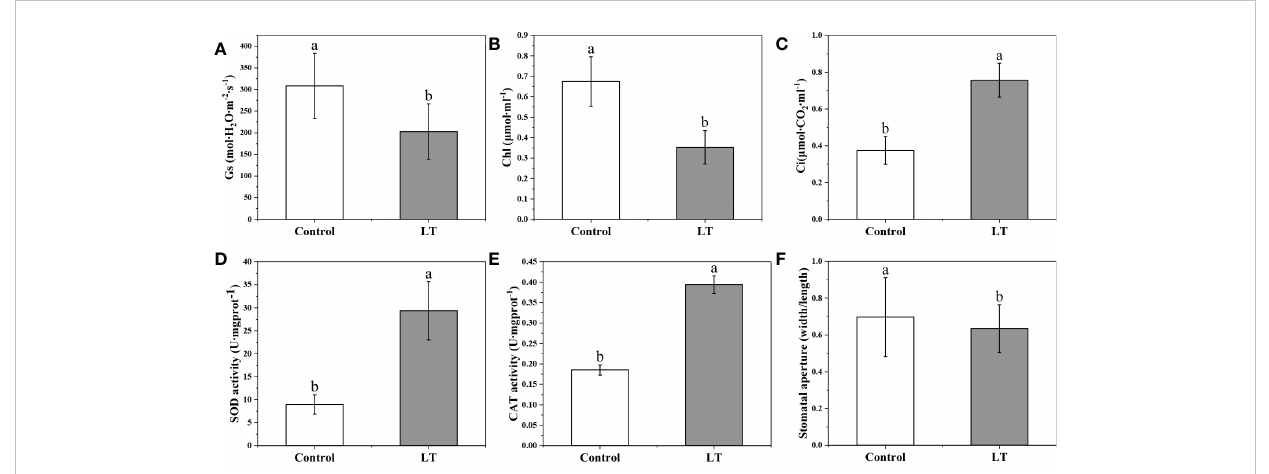
FIGURE 1 Physiological and biochemical reaction to the low temperature stress in Rhododendron chrysanthum Pall. (A) Stomatal conductance (Gs). (D) Superoxide dismutase (SOD) activity activities. (E) Activity of the enzyme (B) Chlorophyll contents (Chl). (C) Intercellular CO 2 concentration (Ci).